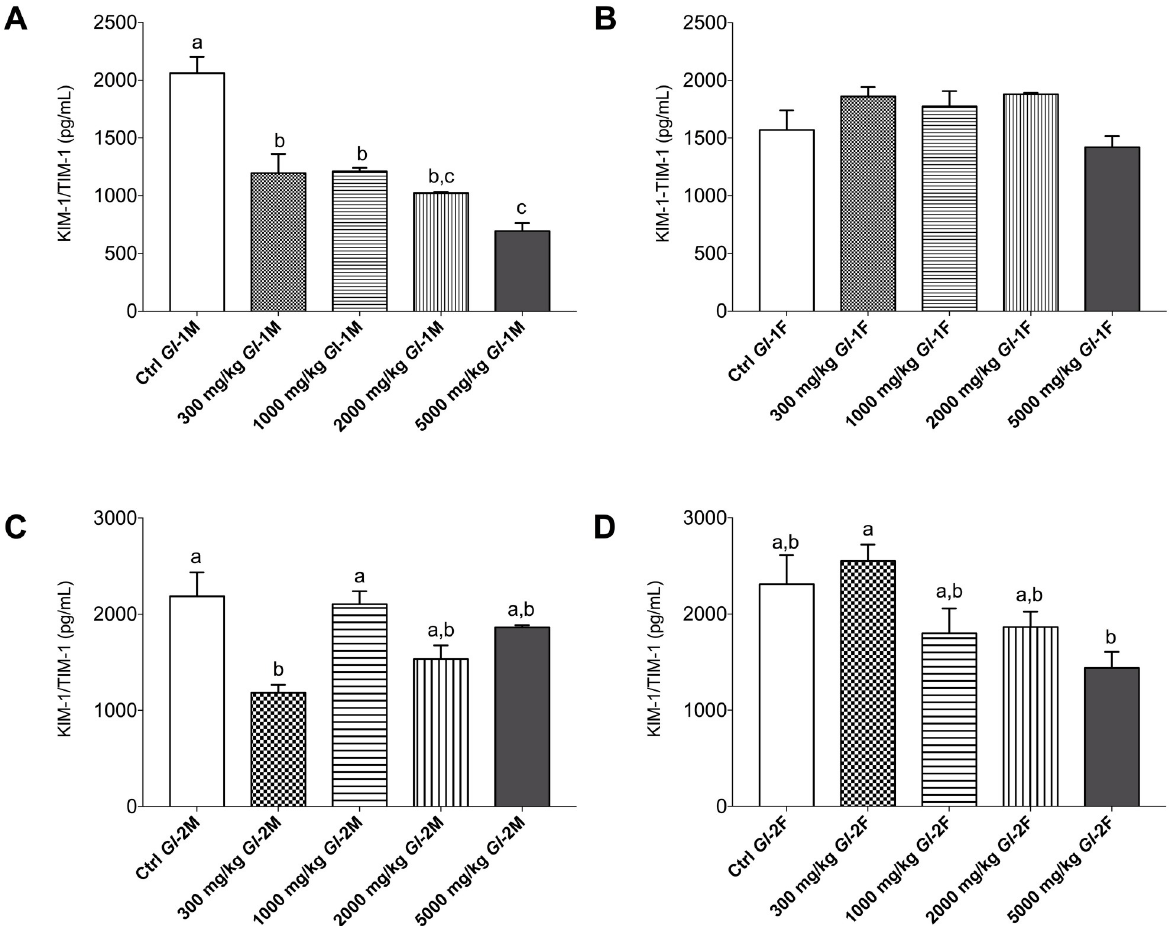
Fig 5. Renal KIM-1/TIM-1 protein (pg/mL) concentration in kidney tissue from the male (M) or female (F) Wistar rats fed with the control diet (Ctrl) and different doses of standardized Gl -1 or Gl -2 extracts of Ganoderma lucidum for 14 experimental days. Data are presented as mean ± SEM per experimental group. Different letters on a column indicate significant differences, p < 0.05. Values ( p ) correspond to one-way ANOVA from Tukey’s multiple comparison test. A–B: Administration of the Gl -1 extract. C–D: Administration of the Gl -2 extract. The dose was administered per experimental group as described in the materials and methods section.